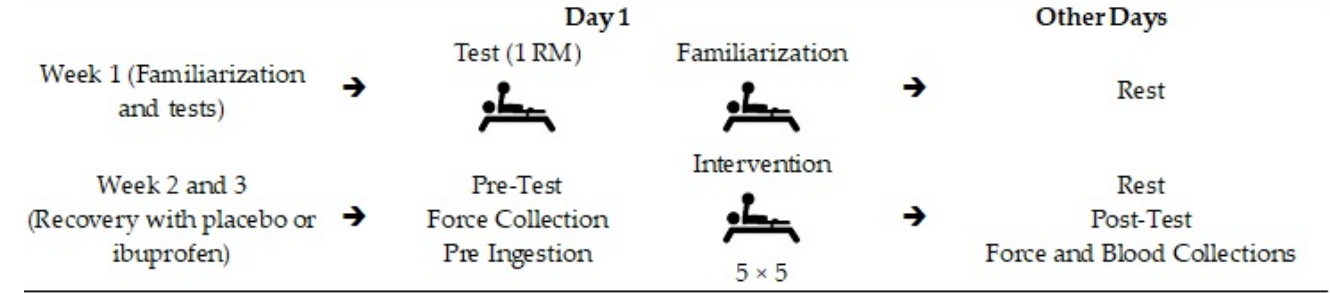
Figure 1. Study design. Legend: → Indicate the order in which the procedures were performed.